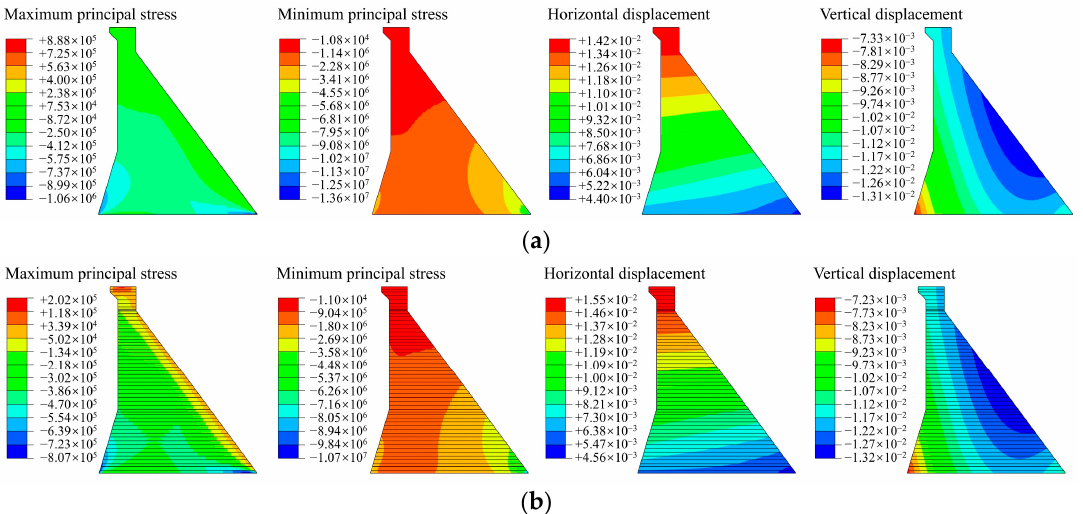
Figure 21. Principal stress and displacement responses of the dam in static analysis. ( a ) Without RCC layers; ( b ) with RCC layers.